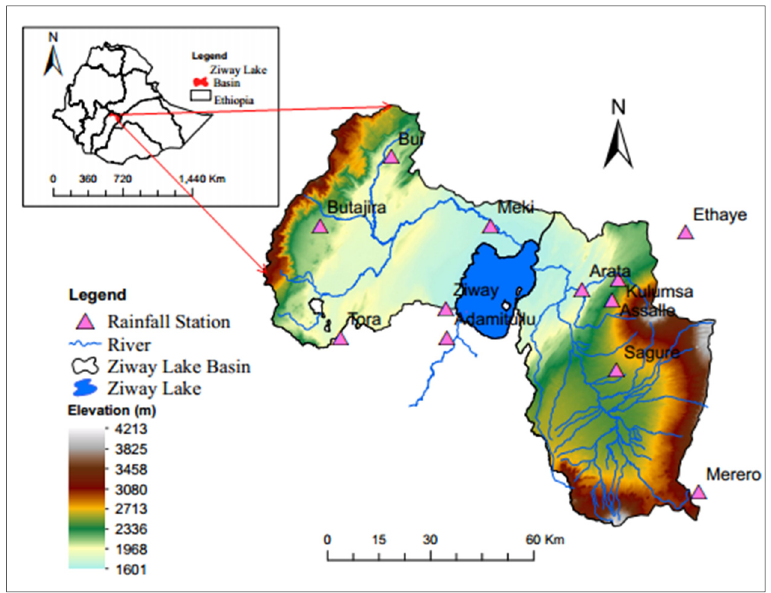
Figure 1. A map of the Ziway Lake Basin, including elevation, rivers, rainfall stations, and Lake Ziway itself .